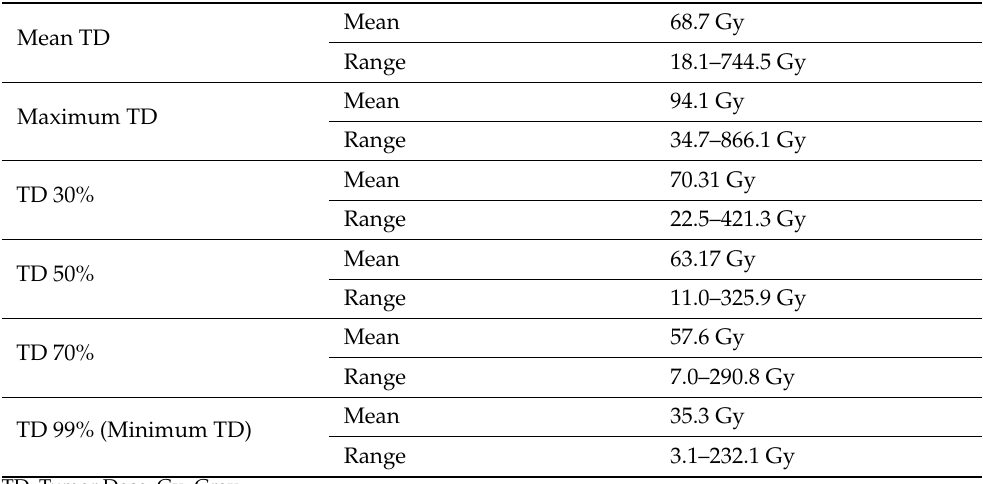
Table 2. Statistics for dosimetry parameters.